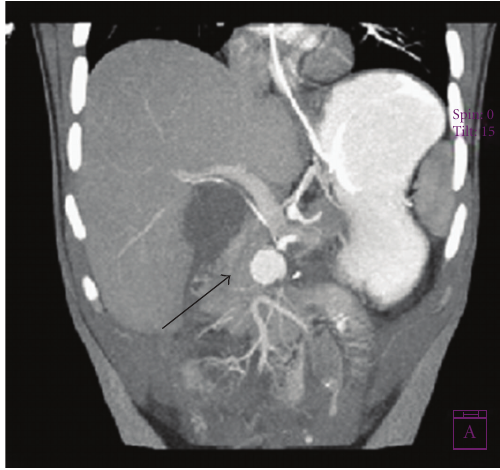
Figure 2: Coronal MPR MSCT angiography showing pseudoa- neurysm and occlusion of part of SMA.